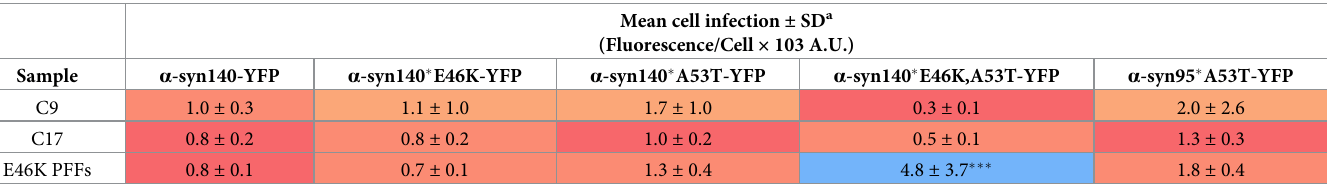
a Colors represent heat map of infectivity with blue indicating high infectivity for a given cell line and red indicating low infectivity for a given cell line. ��� = P < 0.001 compared to control-patient samples C9 and